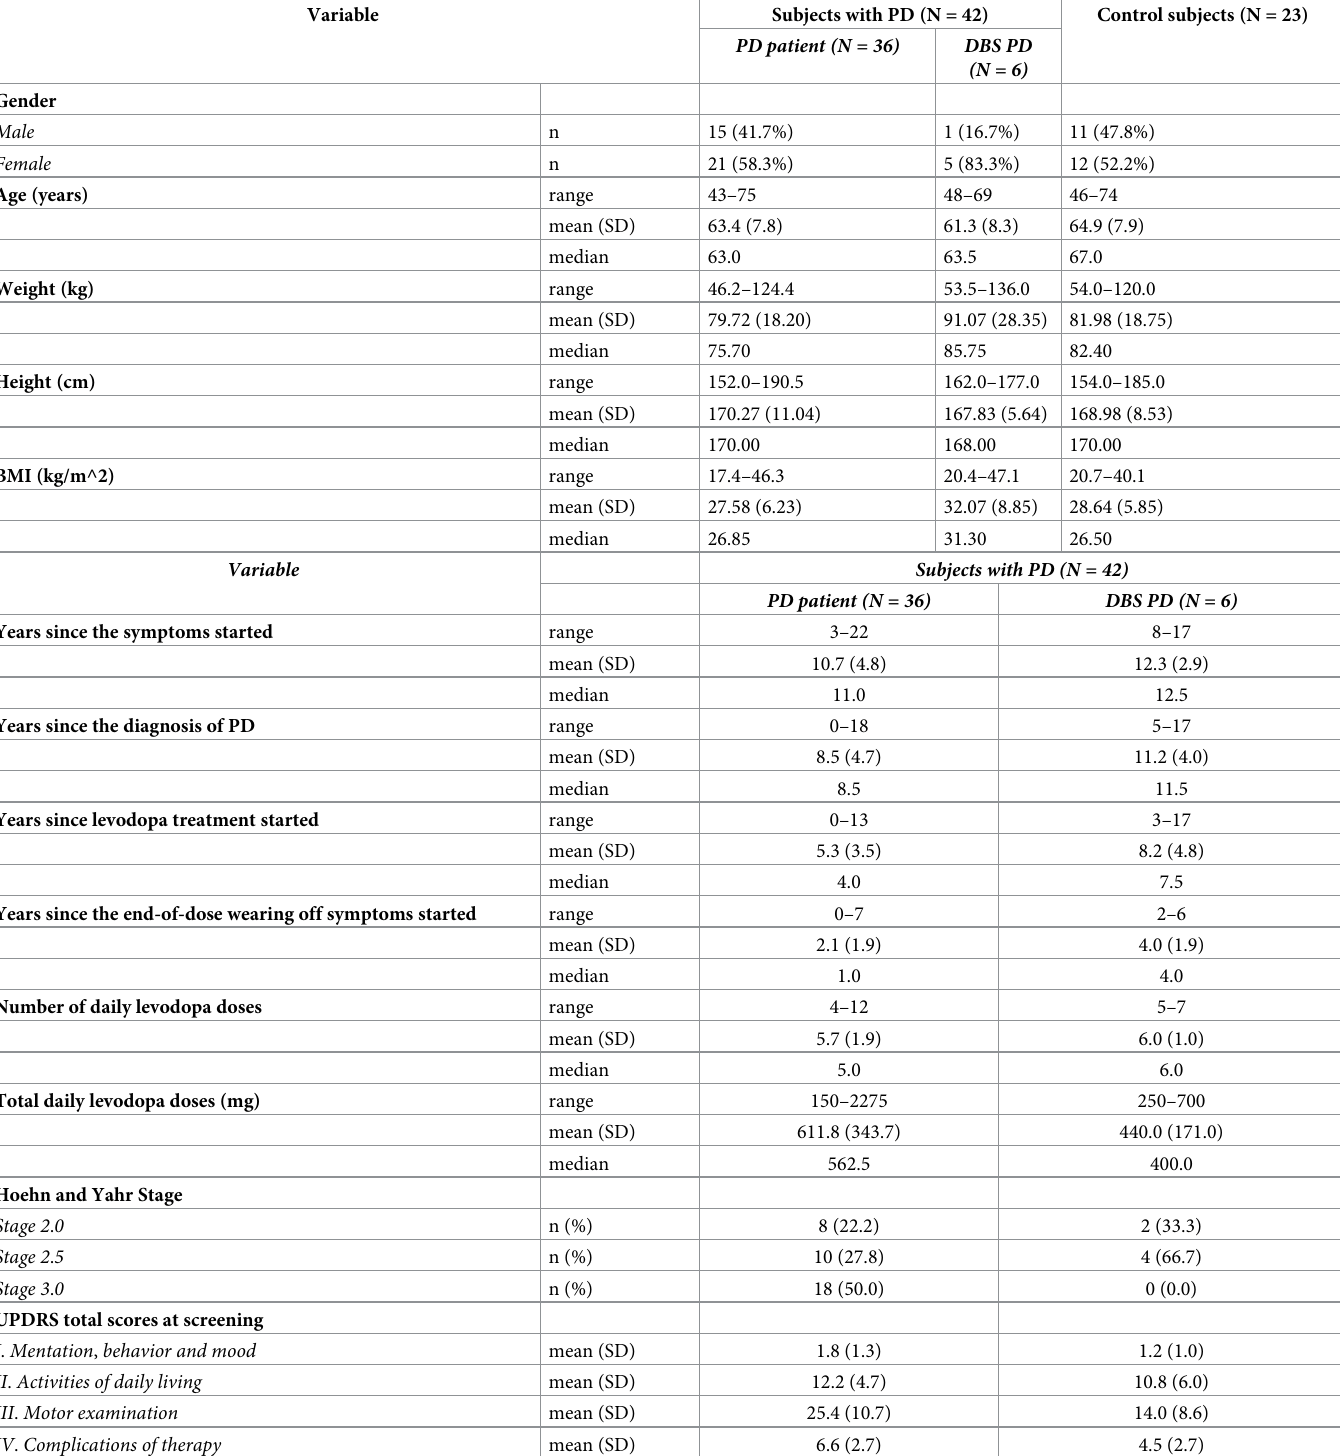
Table 1. Demographics of the study